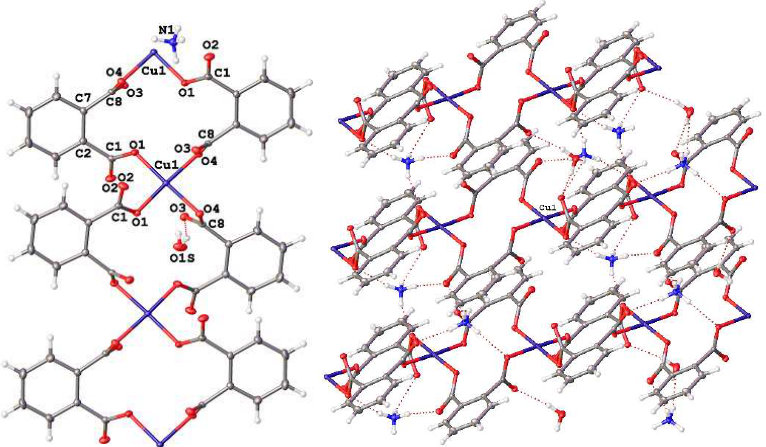
Figure 2. Coordination of o -phthalate ligands to copper ion (left) and crystal packing (right) in III . Hydrogen bonds are presented as dotted lines. Table 1. Bond Lengths for III.